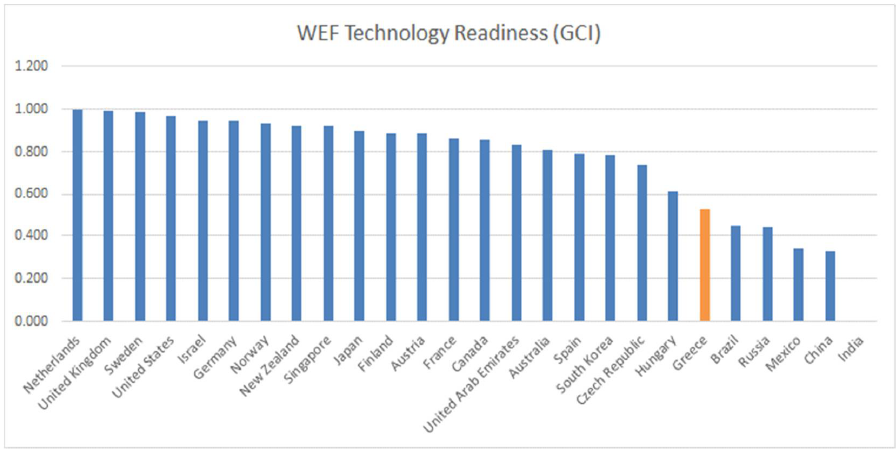
Figure 4. Greece’s AVRI listing in Pillar IV—World Economic Forum (WEF) technology readiness.